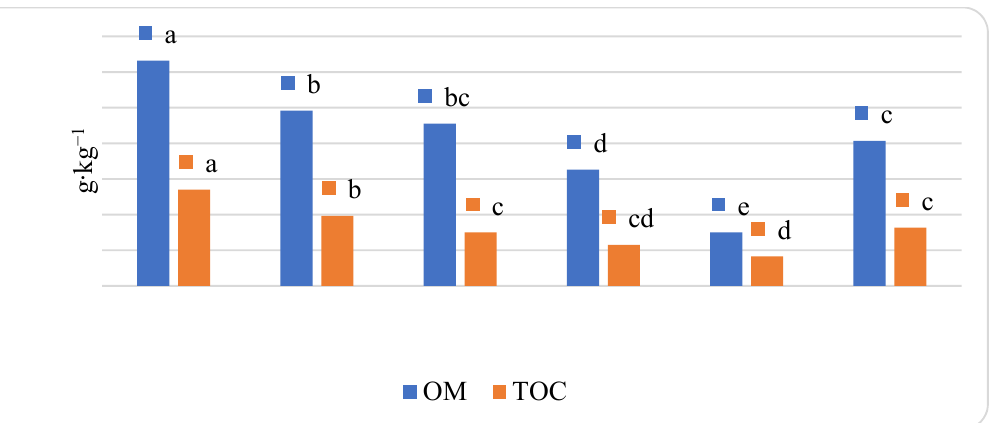
Figure 1. Contents of organic matter (OM) and total organic carbon (TOC) in analyzed vermicomposts and composts (the same lowercase letters indicate homogeneous groups of VCs and Cs).